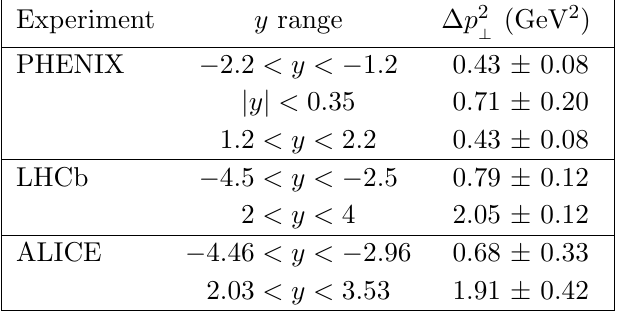
from PHENIX, LHCb and ALICE measurements. ?